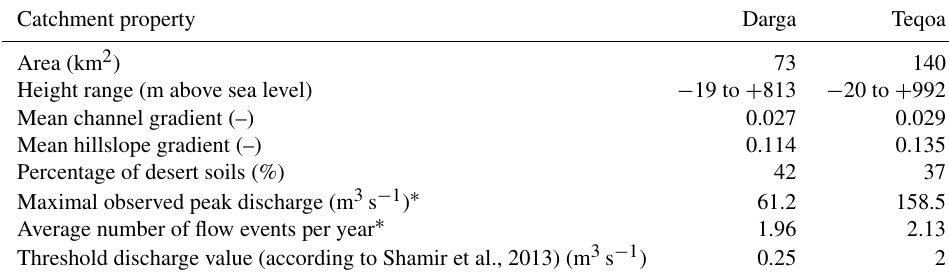
Table 1. Morphological and hydrological characteristics of the Darga and Teqoa catchments. Catchment